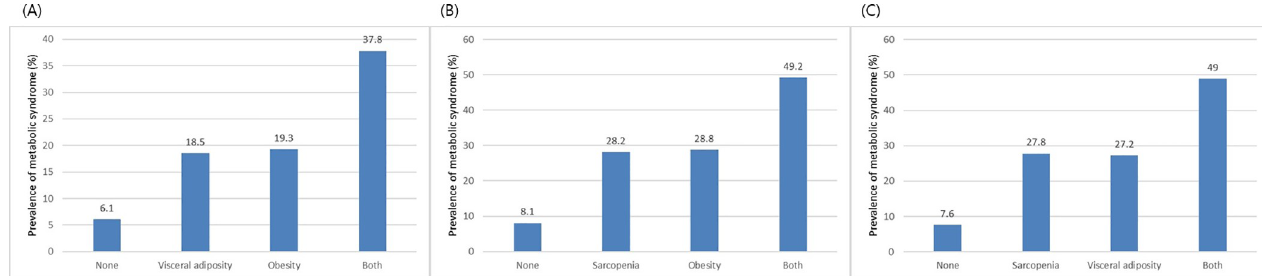
Fig 4. The prevalence of MS in paired analyses according to (A) obesity and visceral adiposity, (B) obesity and sarcopenia, and (C) visceral adiposity and sarcopenia; MS, metabolic syndrome.